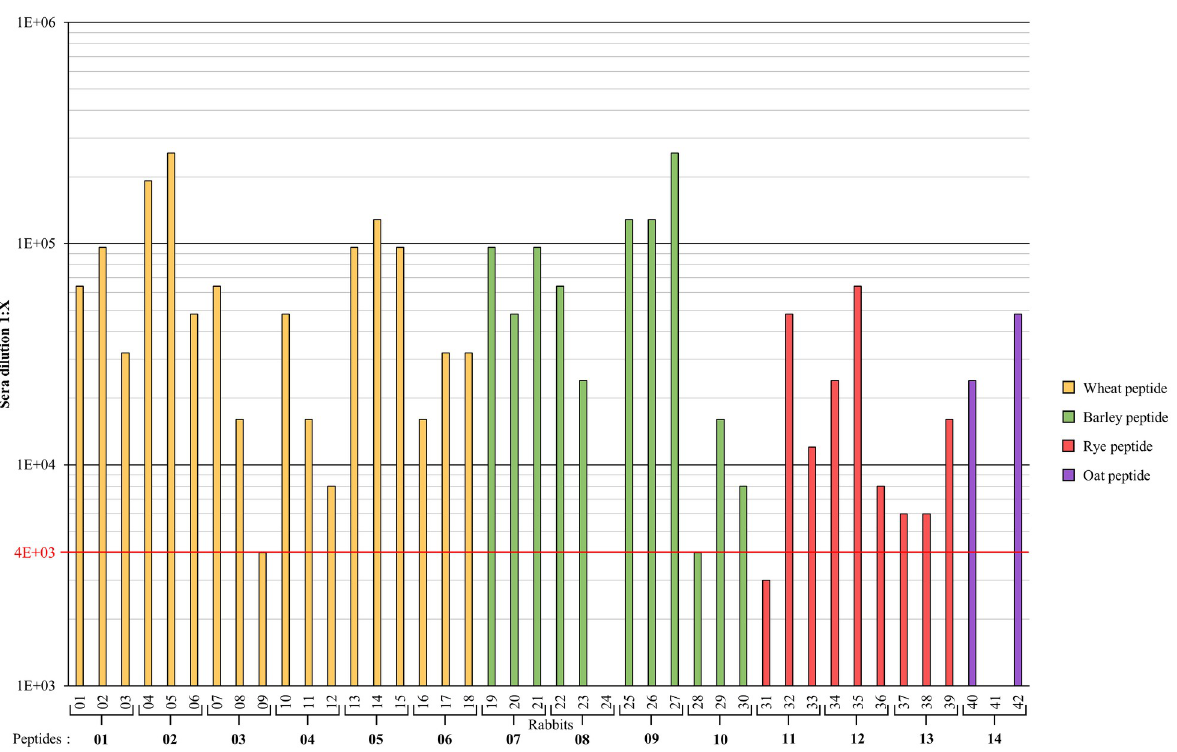
Fig 2. Titer determination by indirect ELISA against 1 μ g/mL of BSA-(Mal-PEG 4 -NHS)-peptide (1–14). Highest sera dilution triggering an O.D. value of � 1.000 at 450 nm. Wheat peptide (01–06); Rabbits (01–18). Barley peptides (07–10); Rabbits (19–30). Rye peptides (11–13); Rabbits (31–39). Oat peptide (14); Rabbits (40–42). Rabbits 24 and 41 died before test bleed 1.